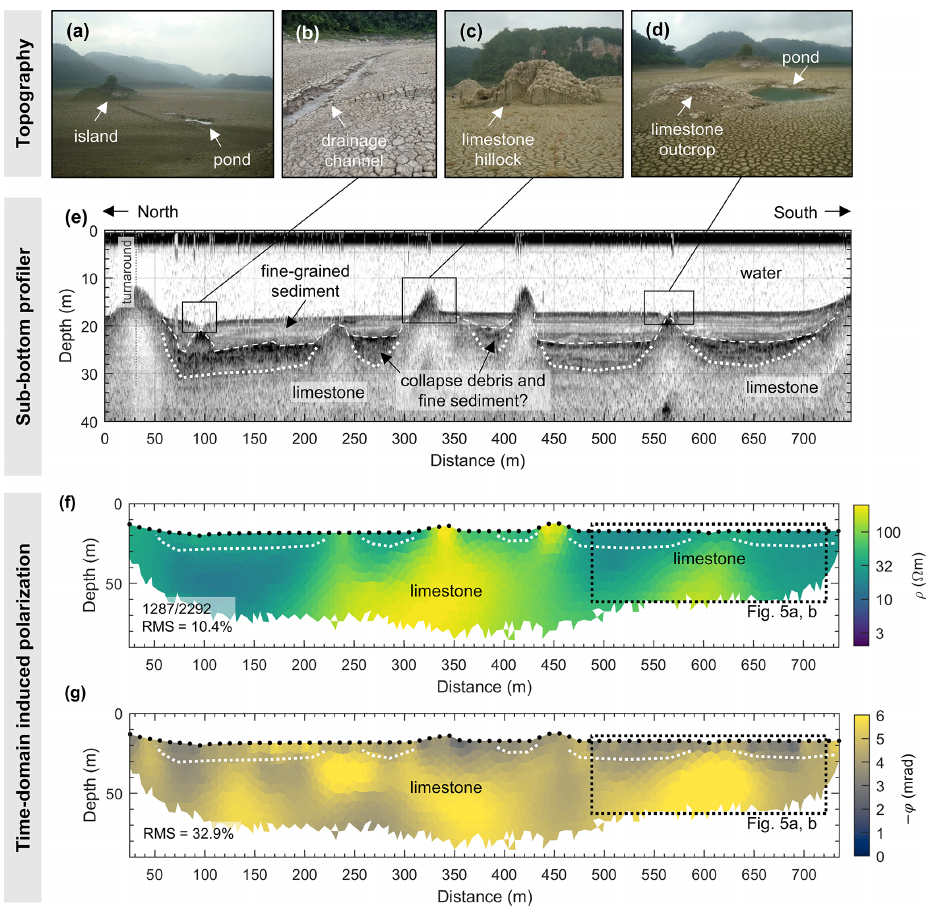
Figure 4. Topographic features and geophysical sections along Profile 1 of Lake Metzabok. Photographs taken in October 2019: (a) lake basin with flat bottom, (b) drainage channel, (c) limestone hillock, (d) deep fracture and pond next to shallow limestone outcrop. (e) Sub- bottom profiler (SBP) section with dashed lines highlighting the main reflector encountered below the lake floor and dotted lines outlining a zone of high diffuse reflectivity. (f, g) Electrical resistivity and phase images, respectively, including electrode positions (black dots along the surface) and dotted lines taken from SBP section. Electrical sections are shifted by 25m with respect to the SPB section. Labels in the lower-left corners of ( f and g ) represent the amount of data points used for the inversion compared to the total measured data (same for resistivity and phase) and the respective percentage root mean square (RMS) deviations of the